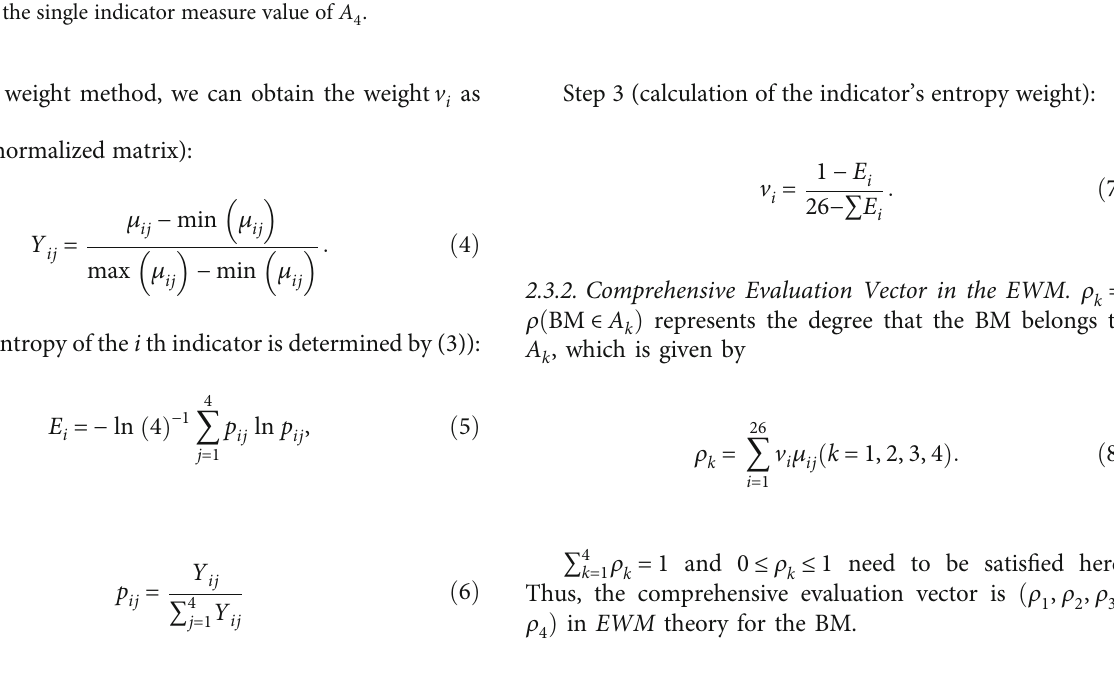
Figure 1: LU uncertainty measurement function for the 7 qualitative indicators and 19 quantitative indicators. The qualitative indicators have the same LU uncertainty measurement function, as shown in “ (i). ” The cyan line indicates the single indicator measure value of A 1 . The carmine line indicates the single indicator measure value of A 2 . The green line indicates the single indicator measure value of A 3 . The red line indicates the single indicator measure value of A 4